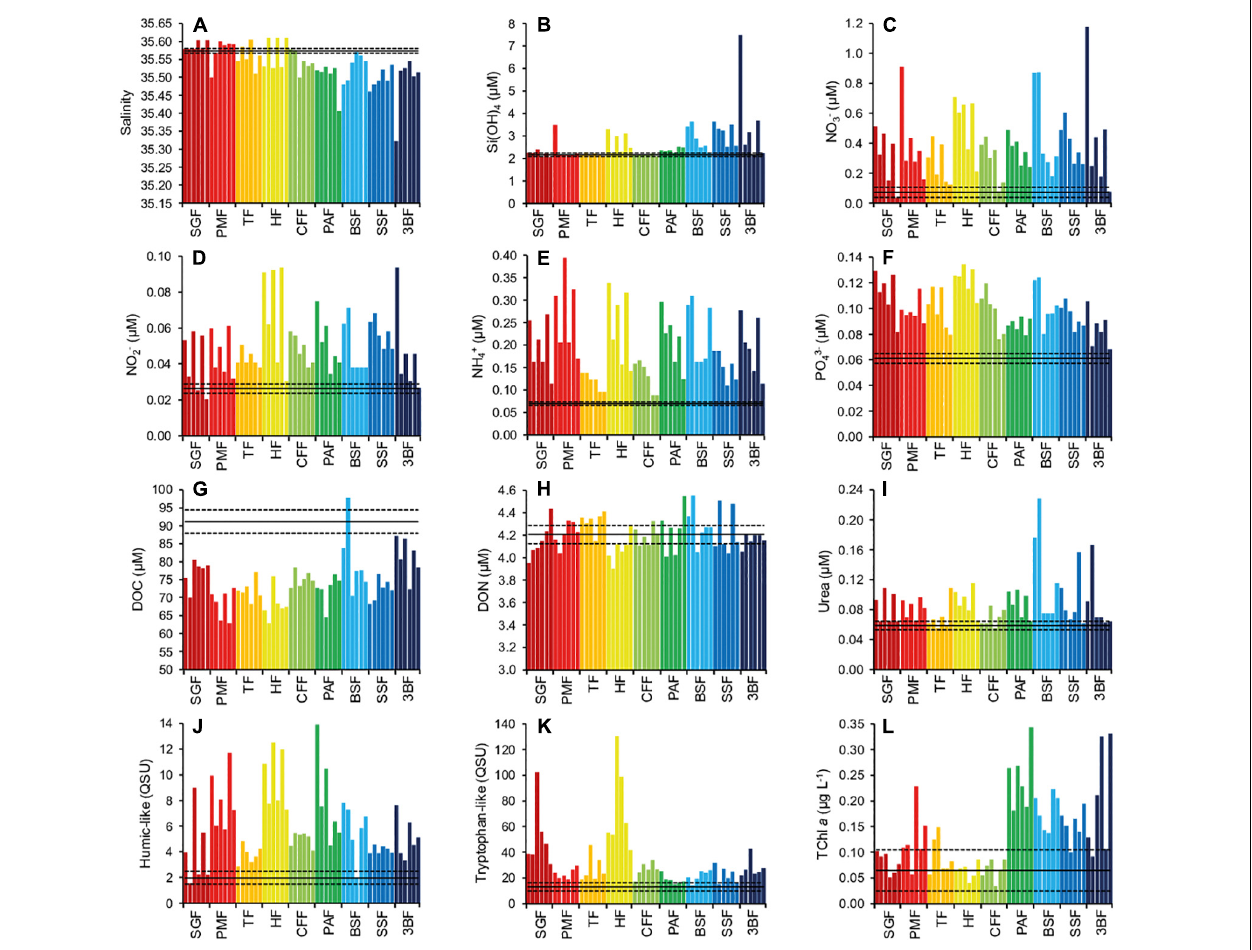
FIGURE 4 | Distribution of salinity and biogeochemical parameters in fore reef waters from north (SGF) to south (3BF) (A–L) . SGF: Saint Gilles River, including SGF1-six samples (dark red); PMF: Poste MNS, including PMF1-six samples (red); TF: Toboggan, including TF1-six samples (orange); HF: Hermitage, including HF1-six samples (yellow); CFF: Camp des Finances, including CFF1-six samples (light green); PAF: Planch’Alizés, including PAF1-six samples (green); BSF: BS4, including BSF1-six samples (light blue); SSF: Sud Sanctuaire, including SSF1-six samples (blue); 3BF: Trois-Bassins, including 3BF1-six samples (dark blue). For each site, from left to right: sample n ◦ 1 to sample n ◦ 6, with sample n ◦ 1 = 5-m depth–surface; n ◦ 2 = 5-m depth–slope; n ◦ 3 = 10-m depth–surface; n ◦ 4 = 10-m depth–slope; n ◦ 5 = 20-m depth–surface; n ◦ 6 = 20-m depth–slope. Black lines correspond to values (full line: mean, dotted lines: standard deviation) recorded in the oceanic water samples, including PMO2 (Poste MNS), PAO1 (Planch’Alizés), and 3BO